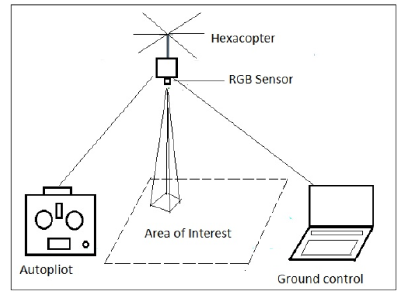
Figure 2. UAV system structure (after Chao et al., 2016)